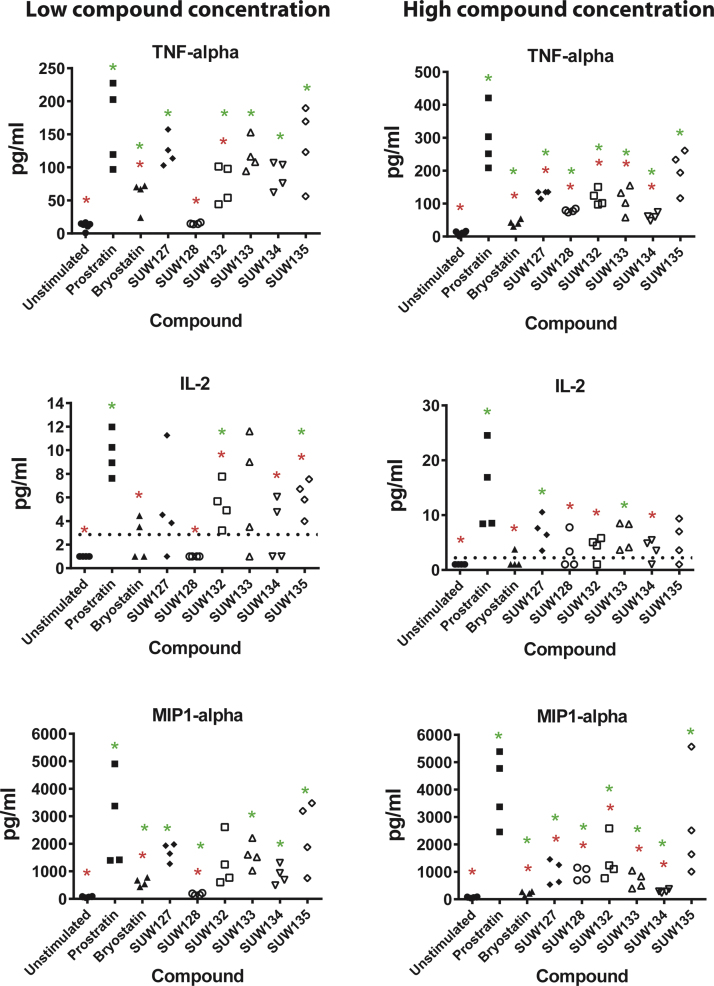
Cytokine induction by compounds in primary PBMC cultures. Primary human PBMCs were exposed to the indicated compound for 18 h and then cytokine concentrations in the culture supernatant were measured using a multiplex bead assay. Results for tumor necrosis alpha (TNF-alpha), interleukin-2 (IL-2), and macrophage inflammatory protein 1 alpha (MIP1-alpha) are shown. Compound concentrations were based on a “low concentration” of prostratin (1 μM) or bryostatin 1 (10 nM) that induces latent HIV expression in approximately 20% J-Lat 10.6 cells. A low concentration of 10 nM was also used for the bryologs. The “High concentration” corresponds to 10 μM prostratin and 100 nM of bryostatin 1 or the bryologs. Broken lines in IL-2 charts indicate the lower level of detection for the assay. Results from two primary cell donors (2–3 individual stimulations for each donor) are presented. Red * indicates p < 0.05 compared with prostratin using a 2-sided t-test. Green * indicates p < 0.05 compared with unstimulated control using a 2-sided t-test.